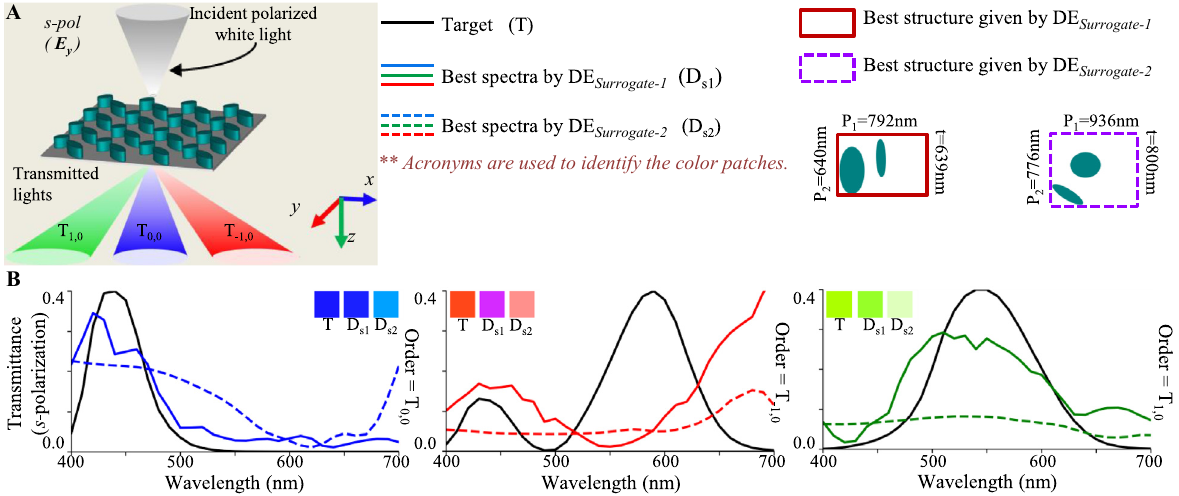
and DE . Surrogate-1 Surrogate-2